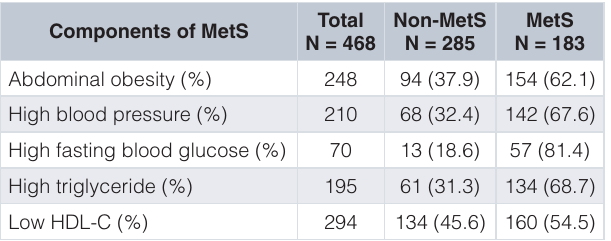
Table 2. Proportion of components of metabolic syndrome (MetS) in the groups of study participants without and with